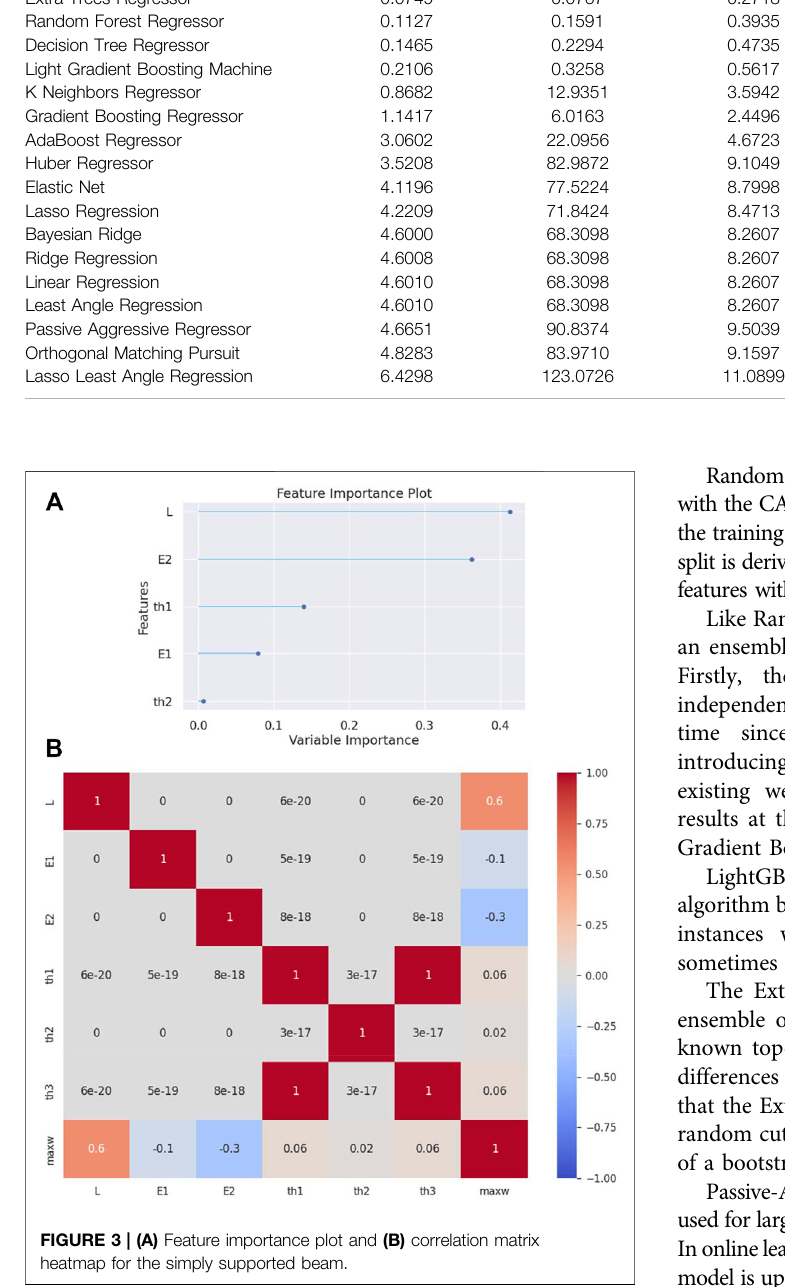
TABLE 3 | Evaluation metrics for the simply supported beam. Model Extra Trees Regressor